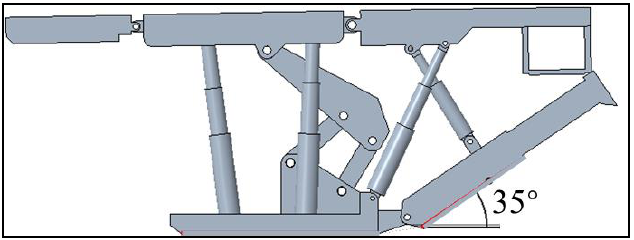
Figure 22. Critical compaction angle of the perforated bottom-dump conveyor.